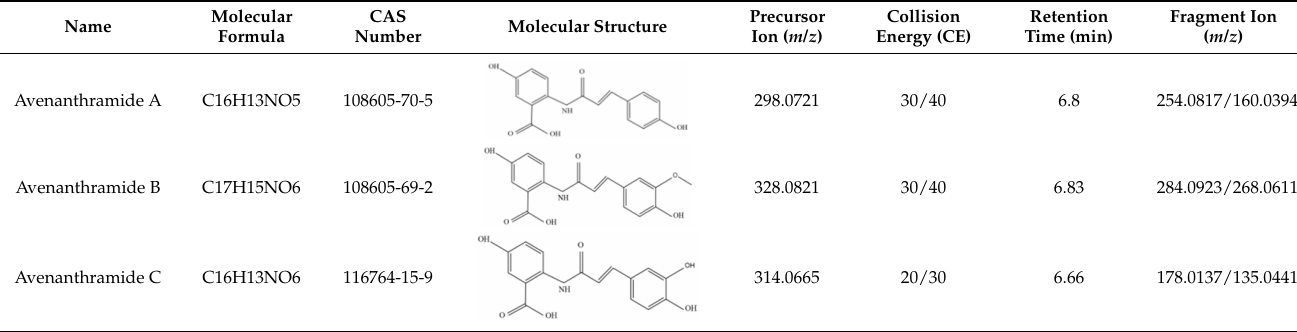
Table 1. Mass spectrometric conditions of the three